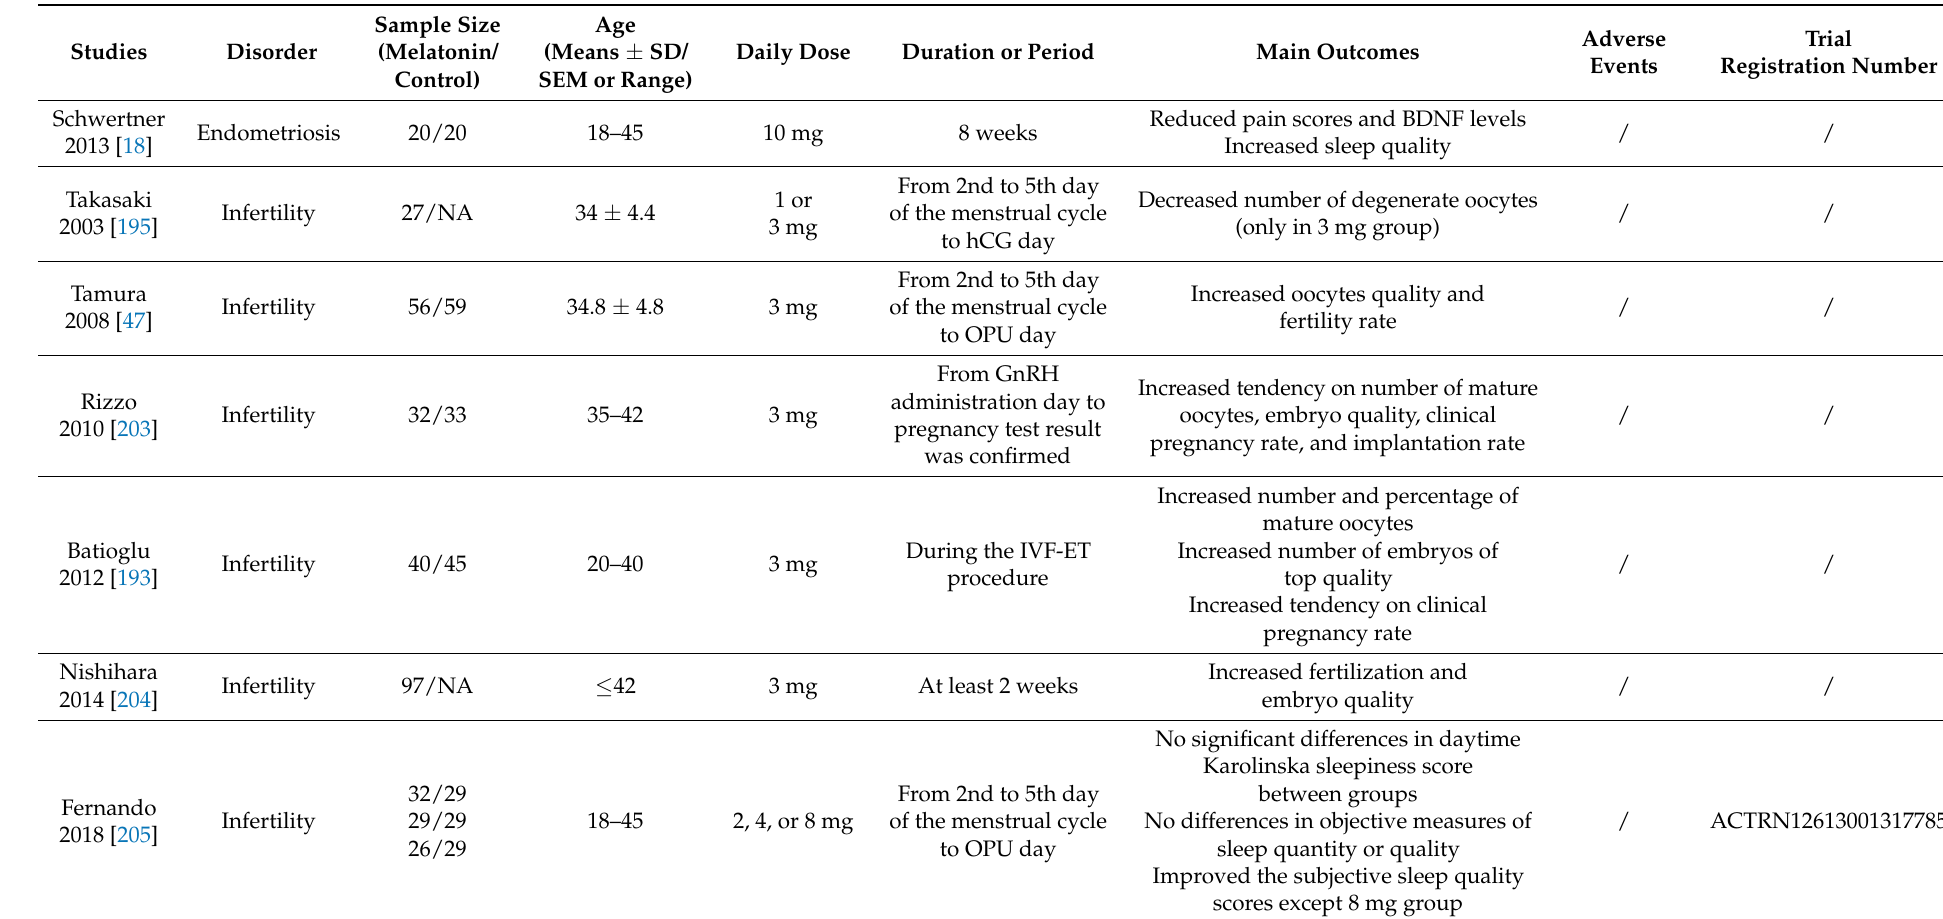
Table 2. Clinical trials of melatonin for endometriosis and other female